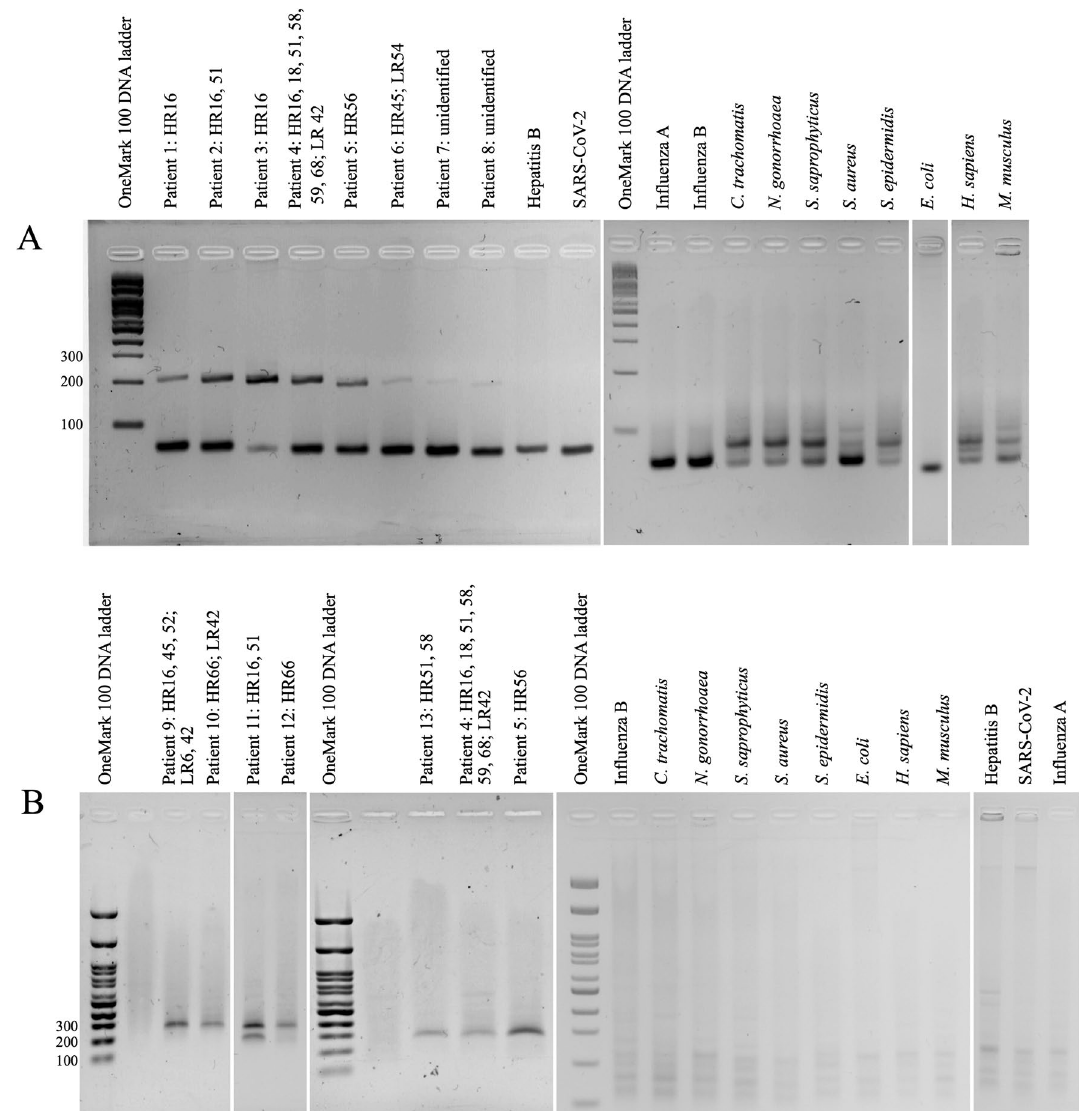
Figure 1. Specificity of our mRPA multiplex primers for L1 and E6/E7 genes by PCR ( A ) and RPA ( B ). Specificity assay included positive (HR types 16, 18, 45, 51, 52, 56, 58, 59, 62, 66; and LR type 6, 42, 54, 70) and negative ( C. trachomatis , N. gonorrhoeae , S. saprophyticus , S. aureus , S. epidermidis, E. coli , hepatitis B, SARS- CoV-2, influenza A and B, Homo sapiens , Mus musculus , and sterile water) controls. Grouping of cropped gels were delineated with white spaces, and original uncropped images were in S1